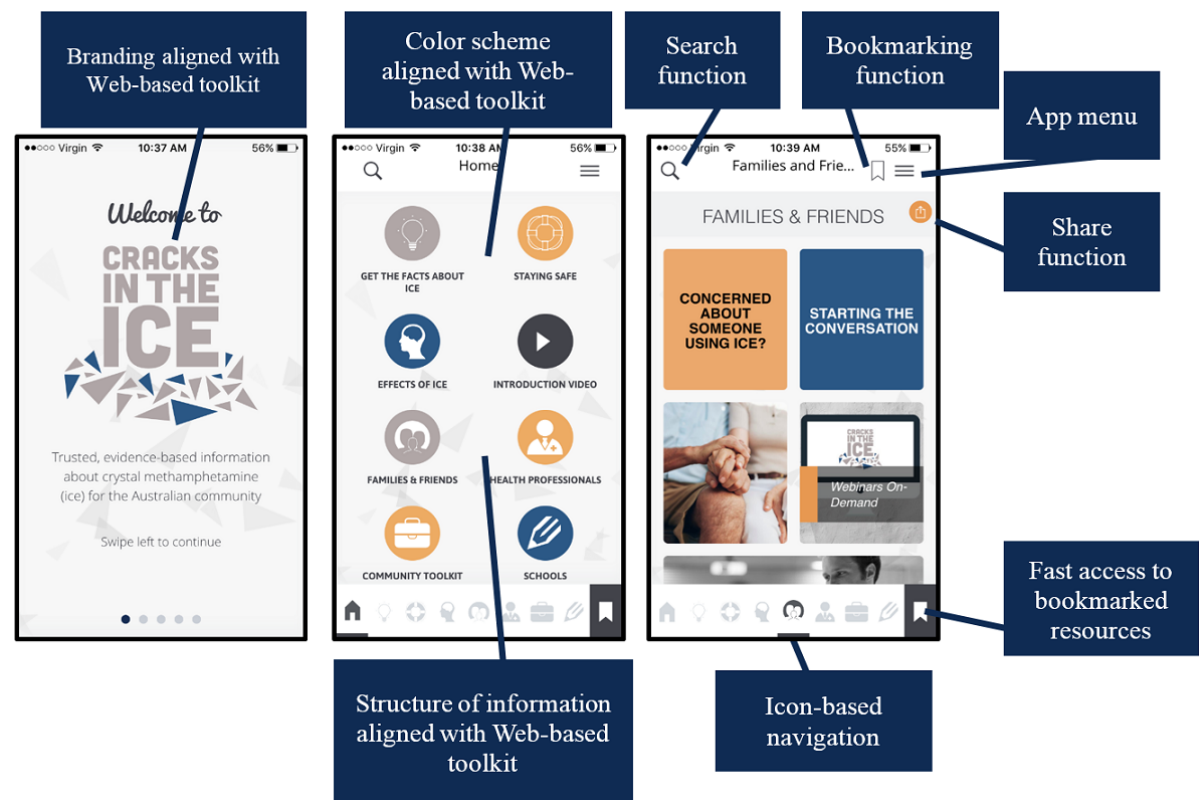
Figure 3. Key design elements and features of the beta version of the Cracks in the Ice mobile